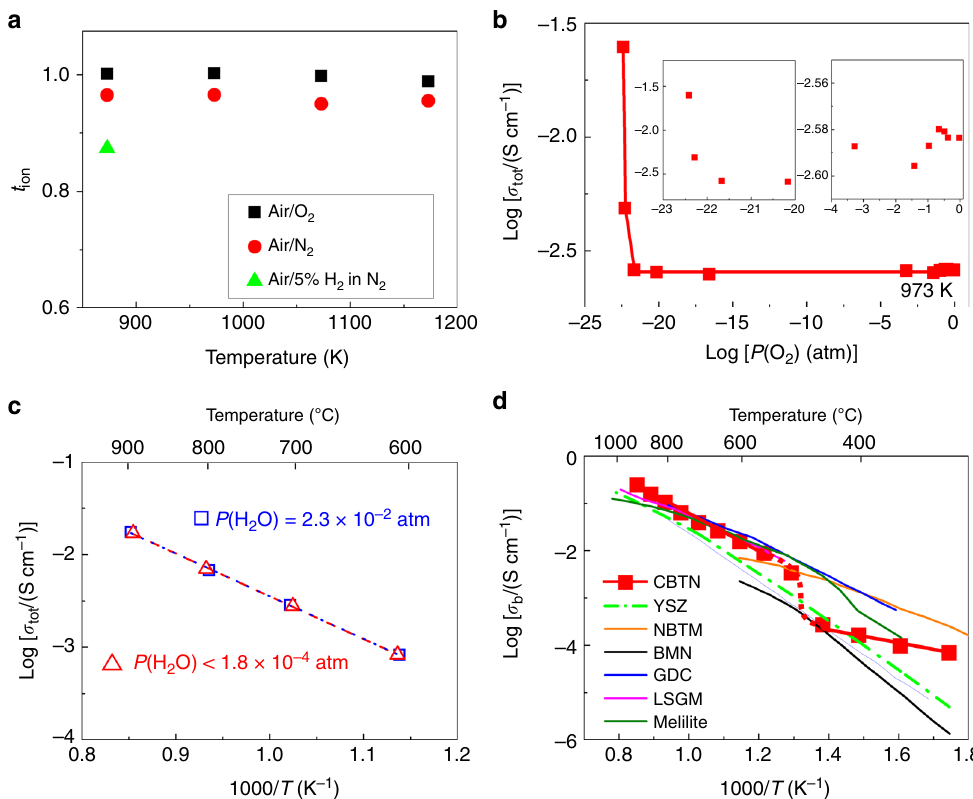
Fig. 3 Oxide-ion conduction of CsBi 2 Ti 2 NbO 10 − δ . a Oxide-ion transport number t ion determined by oxygen concentration cell measurements of CsBi 2 Ti 2 NbO 10 − δ . b Partial oxygen pressure P (O 2 ) dependence of total DC electrical conductivities σ tot of CsBi 2 Ti 2 NbO 10 − δ at 973 K and the insets show the zoom-in view of high and low P (O 2 ) regions. c Arrhenius plots of σ tot of CsBi 2 Ti 2 NbO 10 − δ in dry and wet air. d Comparison of bulk conductivity σ b of CsBi 2 Ti 2 NbO 10 − δ (CBTN) on cooling with those of best oxide-ion conductors: (Y 2 O 3 ) 0.08 (ZrO 2 ) 0.92 (YSZ) 54 , Na 0.5 Bi 0.49 Ti 0.98 Mg 0.02 O 2.965 (NBTM) 55 ,